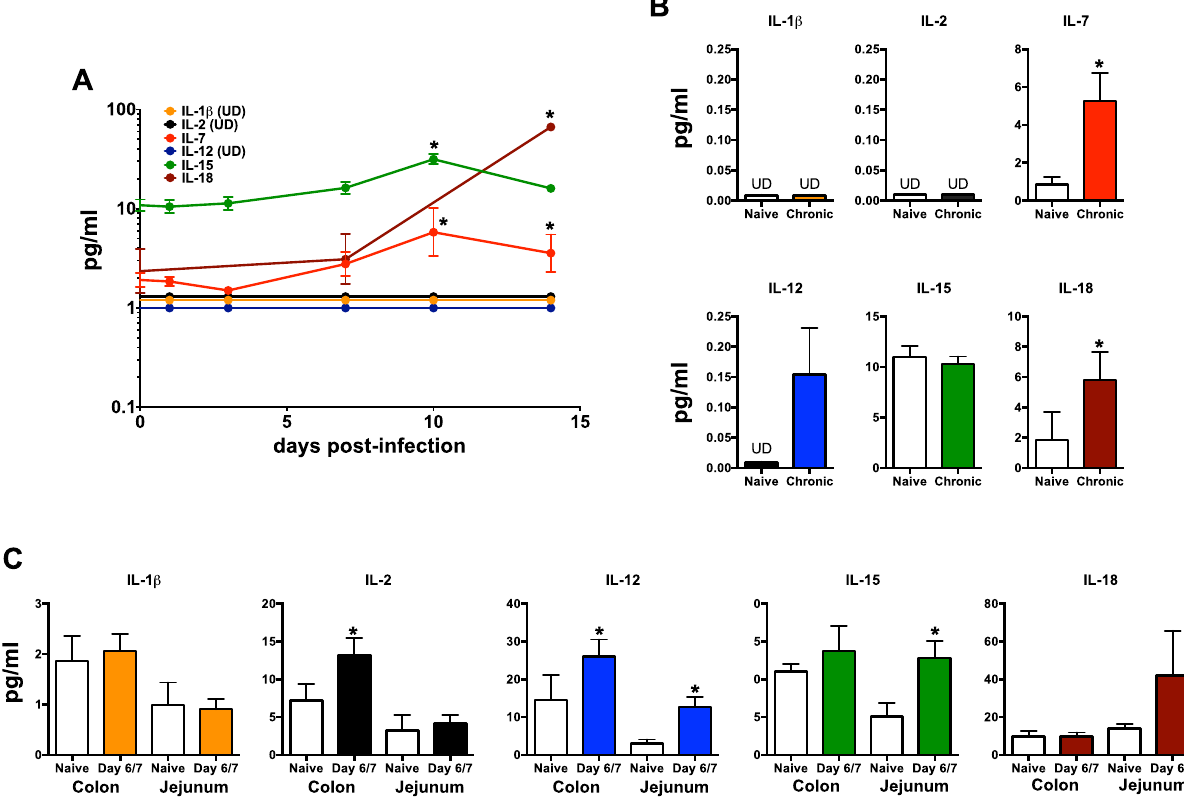
Fig. 6. Quantification of inflammatory cytokines in SIV-infected macaques. (A) Longitudinal cytokine levels in plasma during acute SIV infection. (B) Comparison of plasma cytokine levels in naı¨ve and chronically SIV-infected macaques. (C) Cytokine concentrations in gastrointestinal washes from naı¨ve and SIV-infected macaques sacrificed at days 6/7 post-infection as described in the Methods. Statistically significant differences between pre-infection and post-infection samples (A) were determined by Student’s t test. Mann-Whitney U test was used for cross-sectional comparisons (A & B). Only statistically significant p values are shown; *, p , 0.05. Samples are from naı¨ve macaques (n=6), those sacrificed at day 6/7 post-infection (n=6), and animals sacrificed in chronic disease (n=8). UD,